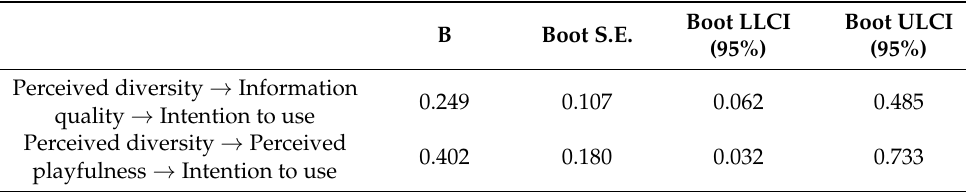
B Boot S.E. 0.249